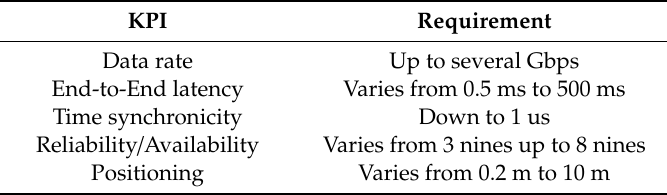
Table 1. Sample of key performance indicator (KPI) requirements from the manufacturing vertical use cases